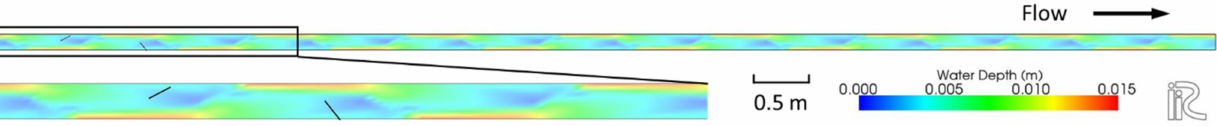
Figure 7. Calculation results for channel pattern and depositional distribution of wood pieces in Case 4 at the end of 18 h. Solid black lines denote wood pieces. The length and diameter of wood pieces are increased by factor of 15 and 20 for visualization,